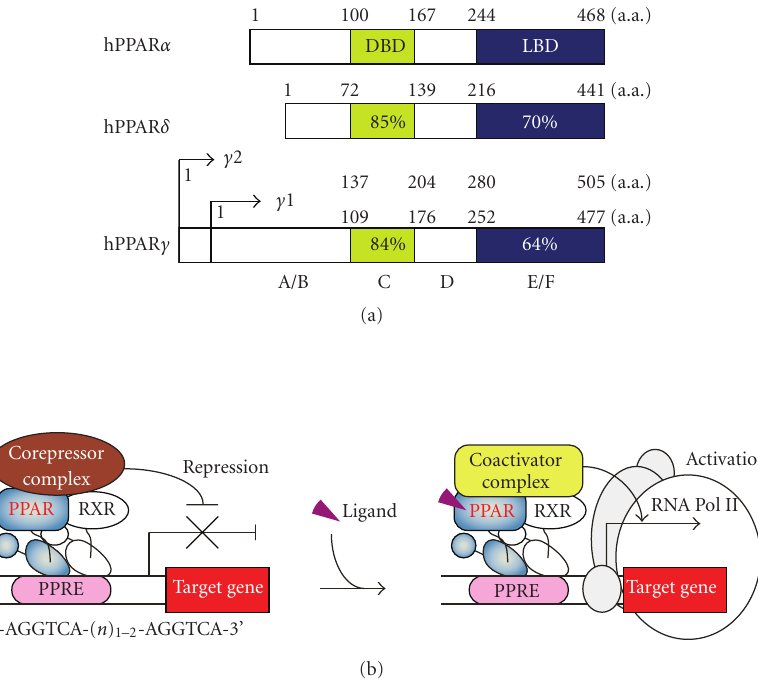
Figure 1: The general features of human PPARs. (a) Structure and functional domain of human PPARs. A/B, C, D, and E/F indicate N- terminal A/B domain containing a ligand-independent activation function 1, DNA-binding domain (DBD), hinge region, and C-terminal ligand-binding domain (LBD), respectively. The number inside each domain corresponds to the percentage of amino acid sequence identity of human PPAR δ and PPAR γ relative to PPAR α . (b) PPAR/RXR heterodimers bind to a PPRE located in the promoter of target genes through the DBD. Unliganded PPAR associates with the corepressor complex. In the presence of ligand, the ligand-bound LBD associates with the coactivator